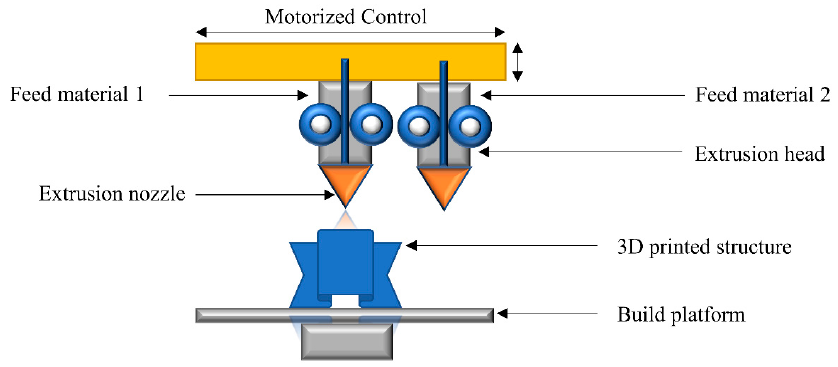
Figure 11. Schematic diagram of the multi-material FFF process. A central motorized controller ad- justs the position of the extrusion heads intermittently for layer-by-layer extrusion of each